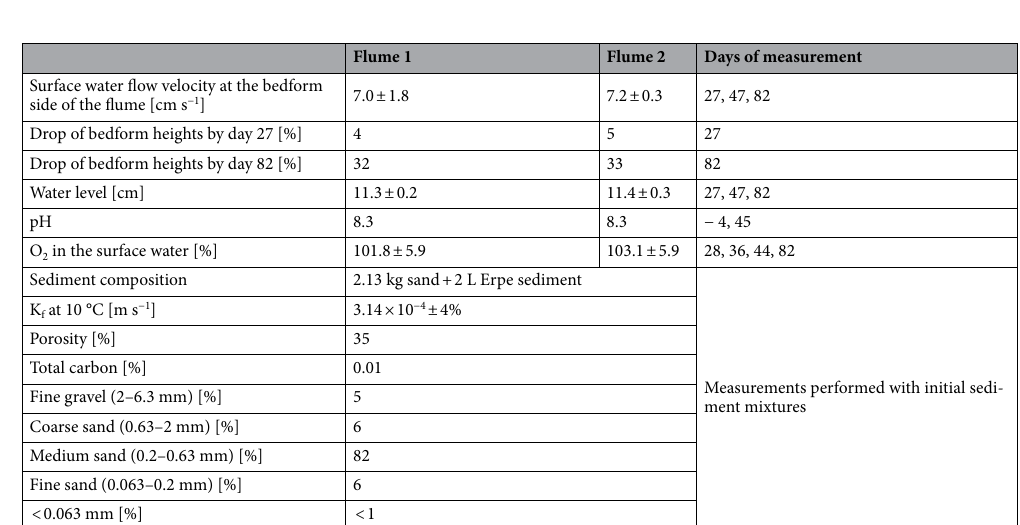
Table 1. Boundary conditions of Flumes 1 and 2, as well as shared sediment properties (mean ± sd).